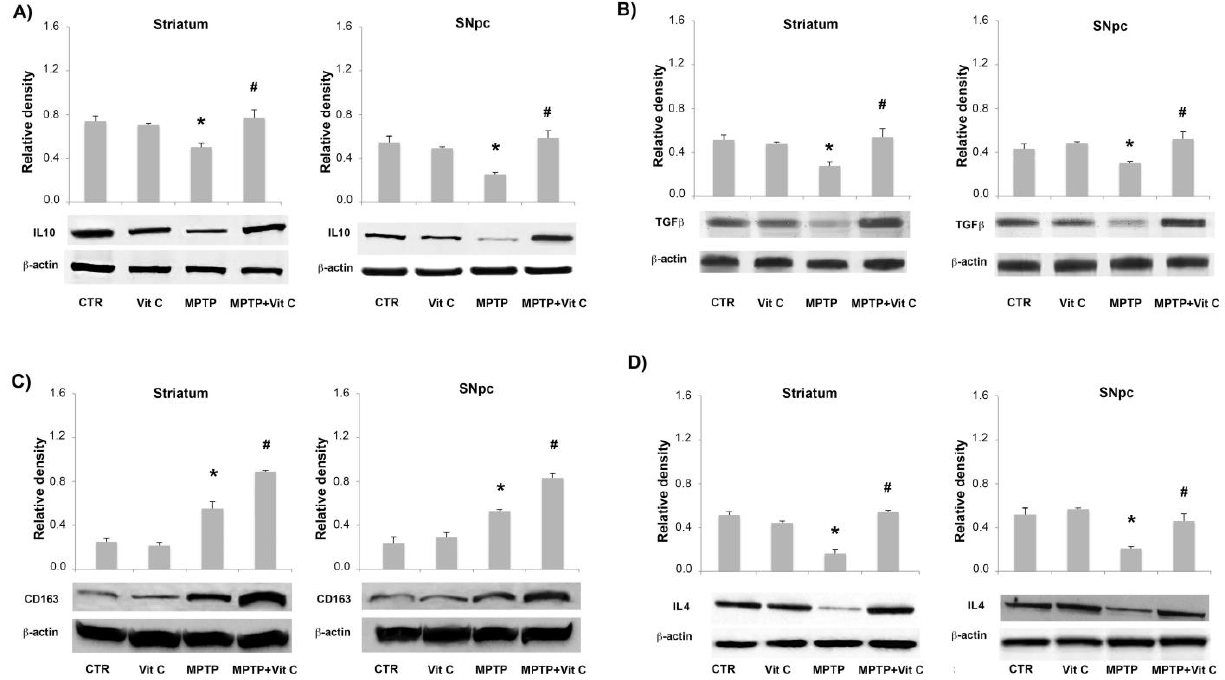
Figure 8. Effects of Vit C on the expression of anti-inflammatory markers in MPTP-treated mice. Western blotting detection and densitometric analysis of ( A ) IL-10, ( B ) TGF- β , ( C ) CD163, and ( D ) IL-4 expression levels in controls (CTR), mice treated with Vitamin C (VIT C), MPTP, MPTP, and Vitamin C (MPTP+ VIT C) in striatum ( left ) and SNpc ( right ). Protein expression analysis values are expressed as arbitrary units after normalization against β -actin, used as a loading control ( n = 5 in each group, 5 replicates). Data are presented as mean ± SD (* p < 0.05 vs. CTR; # p < 0.05 vs. MPTP). Supplementary Figure S5 shows the full western blots of Figure 8.